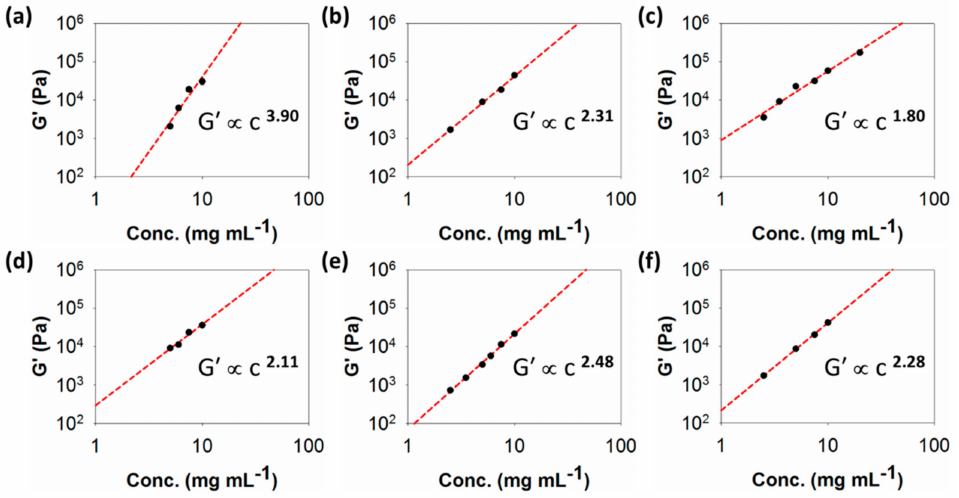
Figure 4. Plots of G (cid:48) against concentration for gels of ( a ) 1 ; ( b ) 2 ; ( c ) 3 ; ( d ) 4 ; ( e ) 5 ; ( f ) 6 . The lines through the data show the fit used to determine the exponent